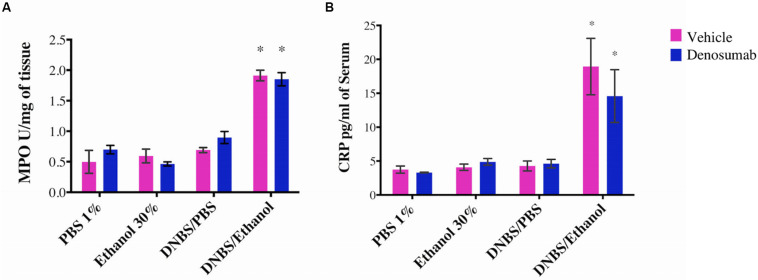
The effects of DNBS/Ethanol-induced colitis and denosumab treatment on regulating the colonic MPO activity and serum CRP. DNBS/Ethanol significantly increased (A). Colonic MPO activity and (B). Serum CRP. Denosumab did not ameliorate the negative effects of DNBS/Ethanol-induced colitic conditions. Vehicle = PBS 1%. Error bars are shown as SEM. *p < 0.001 when compared with other induction models within the denosumab or vehicle group, is calculated using SAS MIXED procedure and illustrated by Prism using two-way ANOVA. n = 6 mice per group.